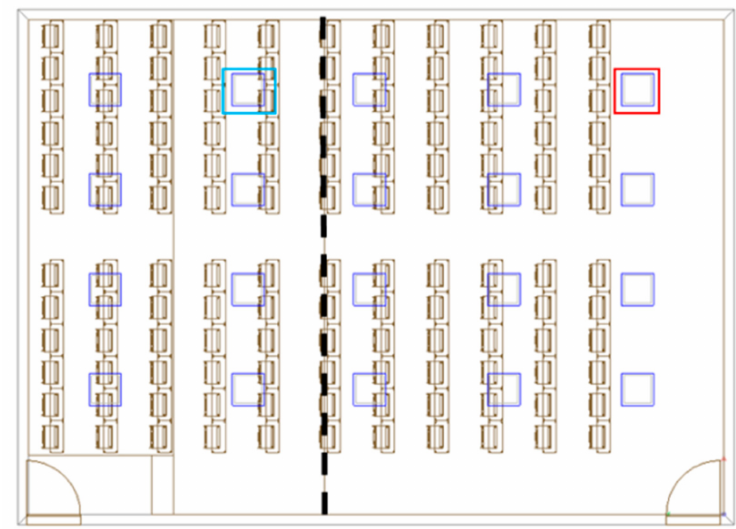
Figure 12. Reconfiguration of lamp location in TR-214 classroom.